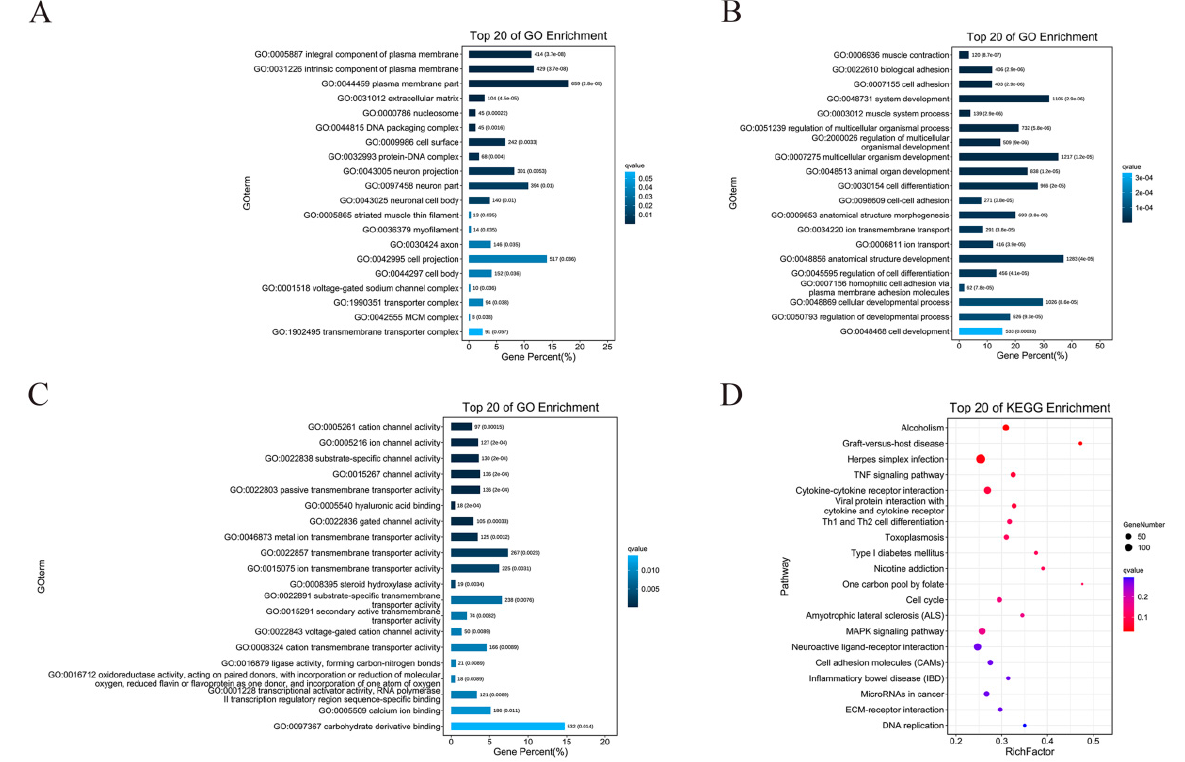
Figure 4. Effects of the cell-free extracts (CFEs) collected from L. plantarum YE4 (YE4-CFE) on GO enrichment and KEGG enrichment analysis. ( A – C ) GO enrichment analysis. ( A ) Cell components. ( B ) Biological process. ( C ) Molecular functions. The horizontal axis represents the percentage of the GO term number to the number of differentially expressed genes (DEGs). The vertical axis represents the GO term information. ( D ) KEGG enrichment analysis. The horizontal axis indicates the rich factor (RF). The vertical axis indicates the pathway. The size of the dots in the pathway represents the quantity of DEGs, and the color of dots denote the different range of q-values. RF refers to the ratio of DEGs enriched in this pathway to the genes annotated to this pathway. The q value is the corrected p value after multiple hypothesis tests. The q value is in the range of 0–1, which, if it is close to 0, indicates more significant enrichment. CFE, treatment group after YE4-CFE interacted with Caco-2 cells; CTL, control group.